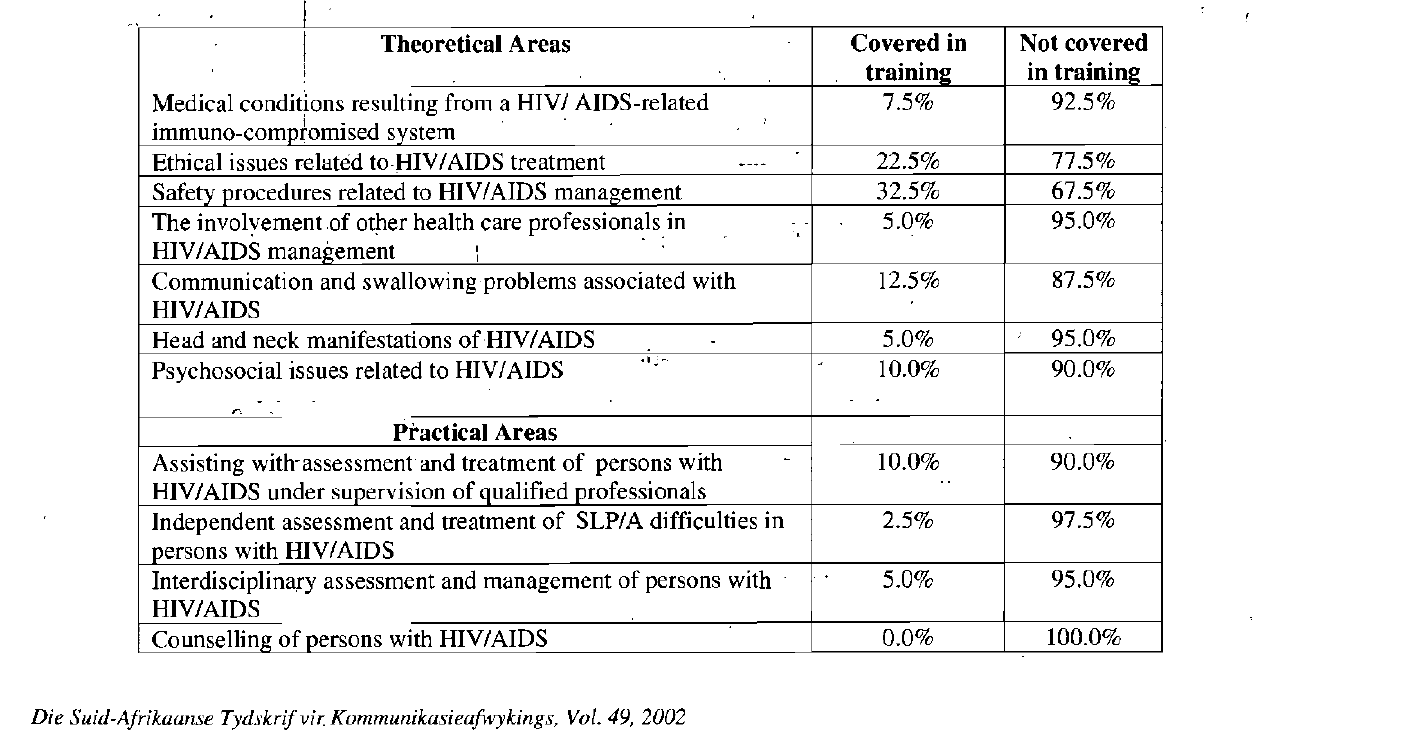
Table 2. Theoretical and practical areas relating to HIV/AIDS covered at undergraduate level (N =